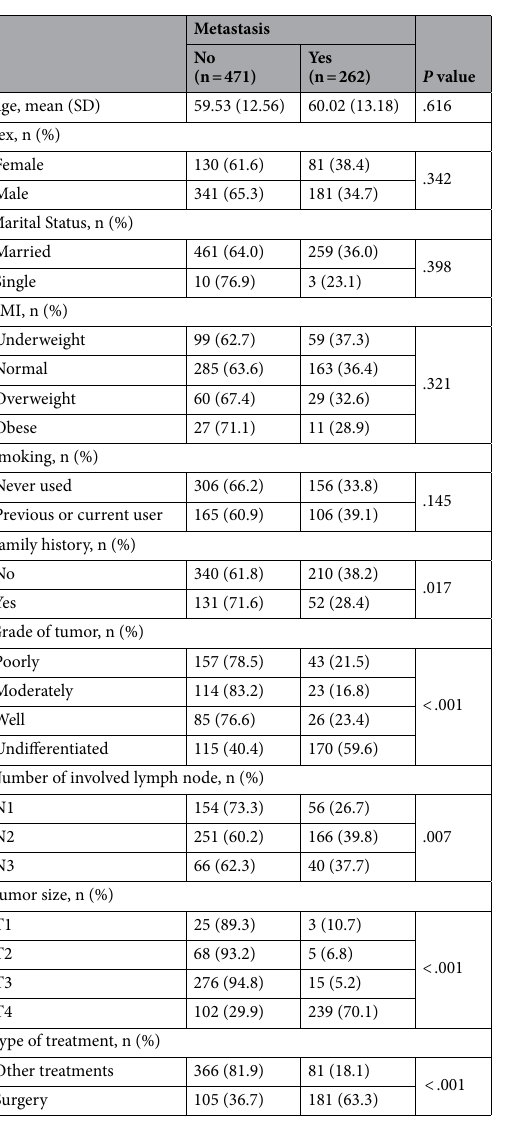
Table 1. Baseline characteristics in patients with GC based on metastatic and non-metastatic